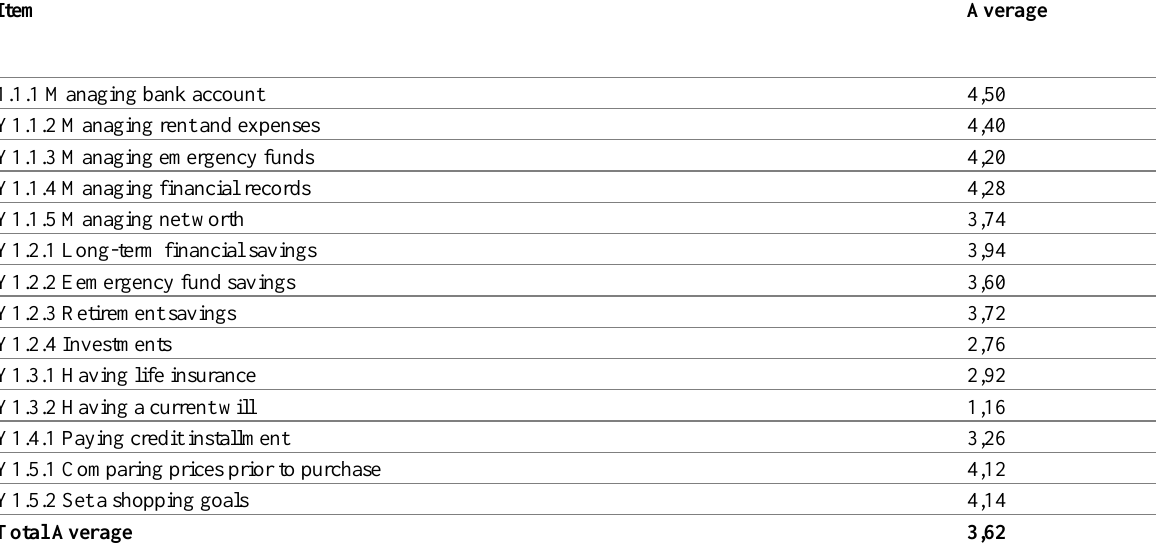
Table 4: Financial Management Behavior Variable Frequency Distribution